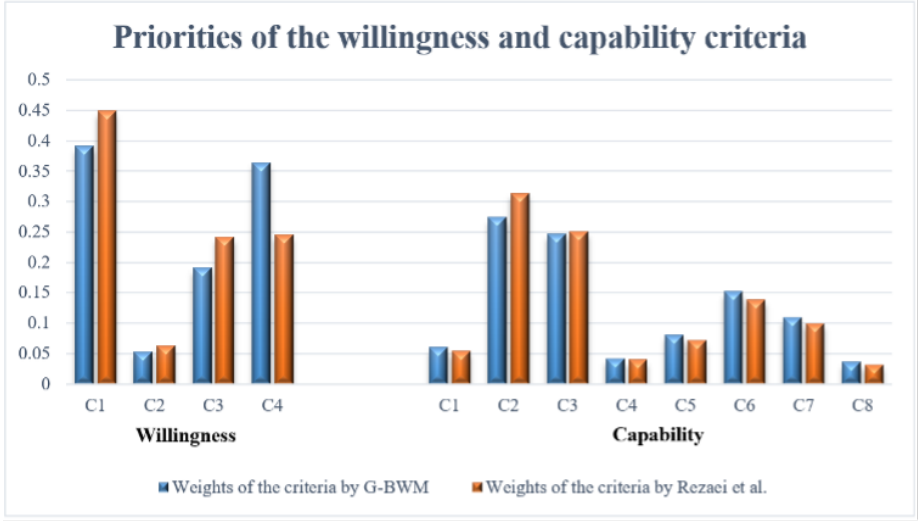
Figure 6. Priorities of the willingness and capability